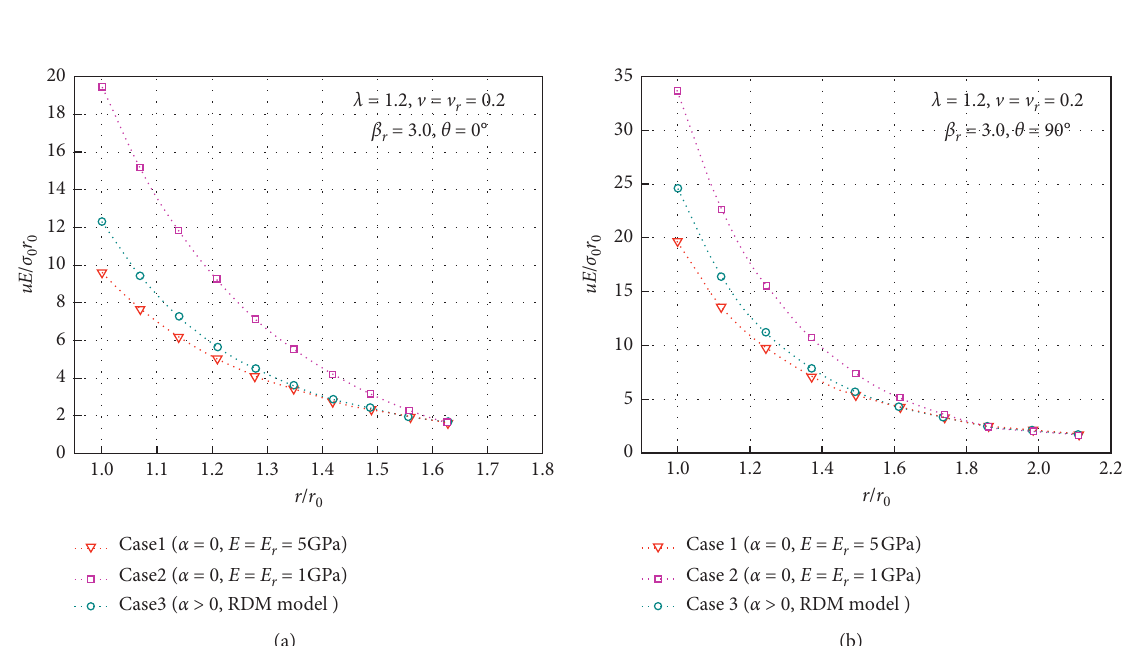
Figure 8: Effect of Young’s modulus attenuation model on the surface displacement of surrounding rock. Soft rock, σ � 0 . 2, and β � 3. (a) The curve at side position (0 ° ). (b) The curve at the roof (90 ° ). v � v r r